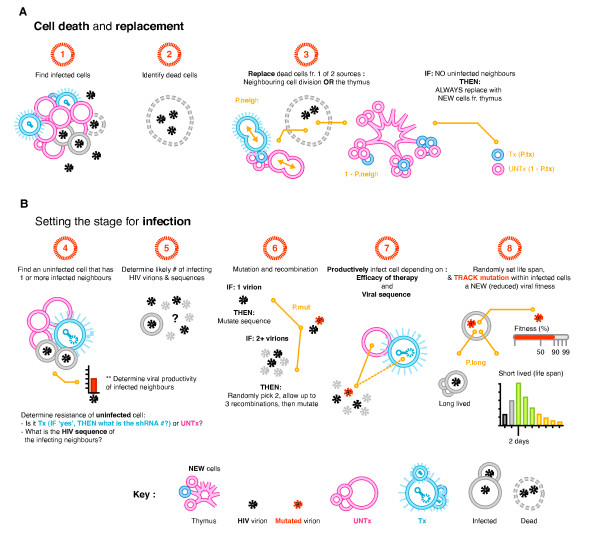
Key steps, decision points and probabilities of the 3 D stochastic model. The following parameters were used to determine cell death and replacement, and infection. Cells that do, or do not, contain the integrated gene are referred to as transduced (Tx) or untransduced (UNTx) respectively. Tx or UNTx cells can either be uninfected or infected. (A) The replacement of an infected cell is determined by (1) finding the infected UNTx or Tx cells, (2) identifying the infected dead cells, and (3) replacing them with cells divided from uninfected neighbours or newly matured from the thymus (B) Infection is established by (4) finding an uninfected cell with at least one infected neighbour and determining the protection of the uninfected cell, i.e. is it UNTx or Tx (and with how many shRNAs)? (5) The status of the infected neighbour is used to determine the likely number of virions produced and their sequence. (6) The virion sequence is mutated and recombined as necessary. (7) Cells are infected depending on the infecting viral sequence, any inhibitory shRNA, and chance. (8) The life span of the newly infected cell is randomly assigned and the viral fitness is adjusted according to its mutations/recombinations. Probabilities: P.tx (set at either 0.2 or 0.01): the percentage of Tx CD34+ hematopoietic stem cells (HSC) resulting in this percentage of cells exported from thymus containing gene product. P.neigh (set at 0.99): the replacement by an uninfected neighbour, compared to a cell from the thymus. P.mut (set at 3.4 × 10-5): the mutation rate per nucleotide. Viral productivity: determined by viral fitness, the transduction state of the infected cell (Tx or UNTx) and the number of mutated sequences. Life span: Poisson distributed with mean 2 days, measured in 12-hourly intervals. P.long (set at 0.0183): probability that an infected cell is long lived.